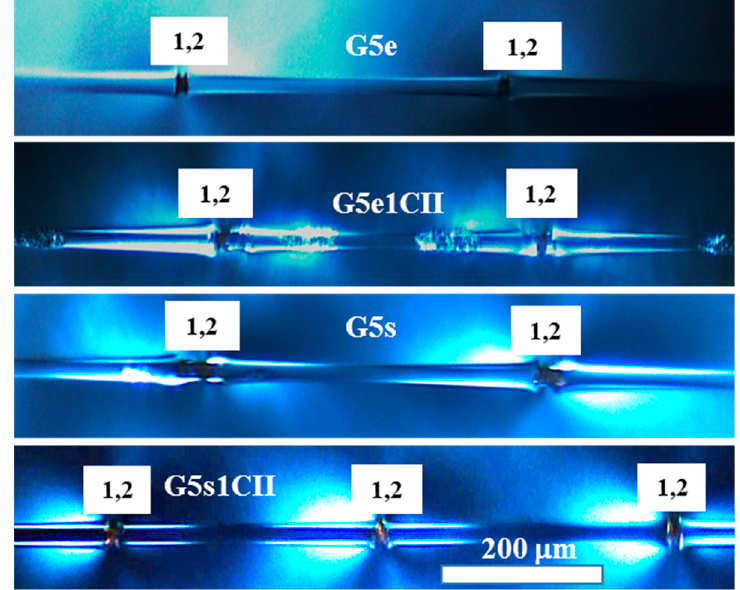
Figure 8. The photoelastic e ff ects of the SFFT for epoxy-based coating formulation samples: G5e, G5e1CII, G5s, and G5S1CII.